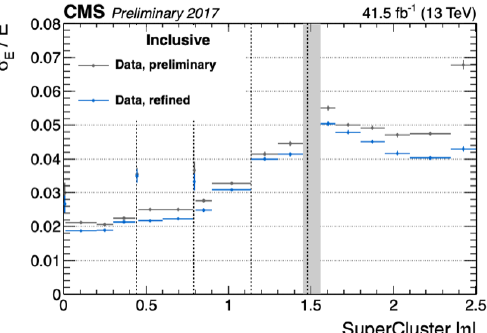
Figure 4. Relative electron energy resolution as a function of the pseudo-rapidity η for the ECAL Barrel and Endcaps, for the preliminary processing (grey) and for the “ultra-legacy” reprocessing (blue) of 2017